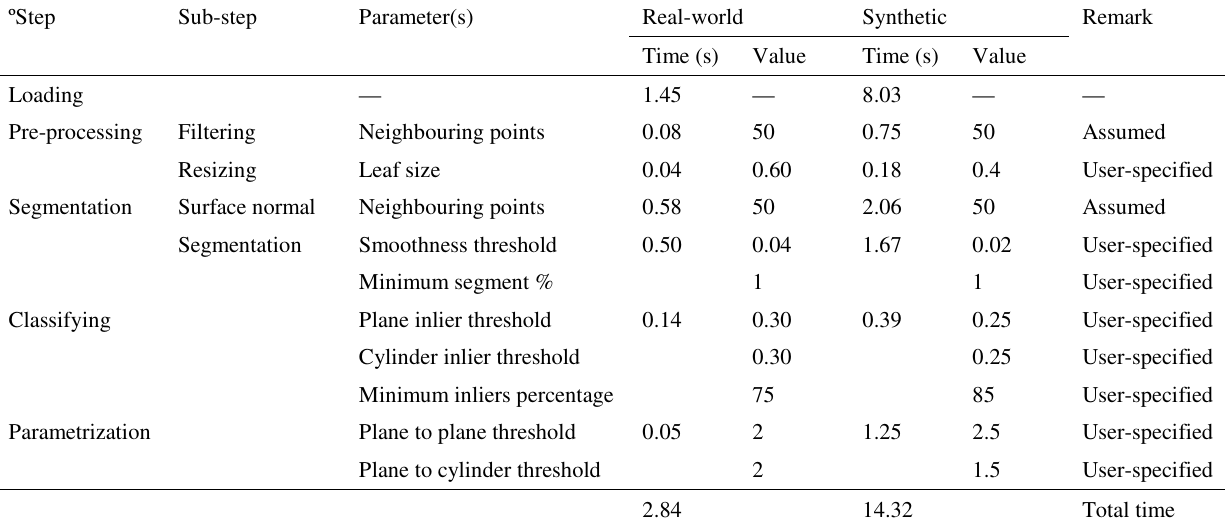
Table 2: Parameters selection and time consumption for each modelling